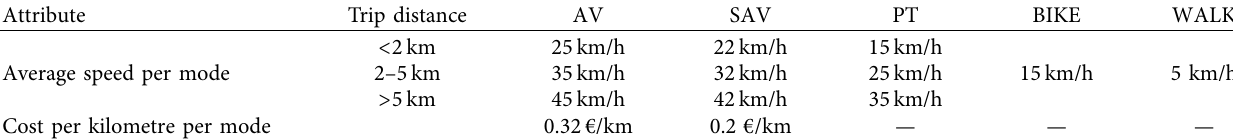
Table 1: Speeds and cost per kilometre for each transport mode.